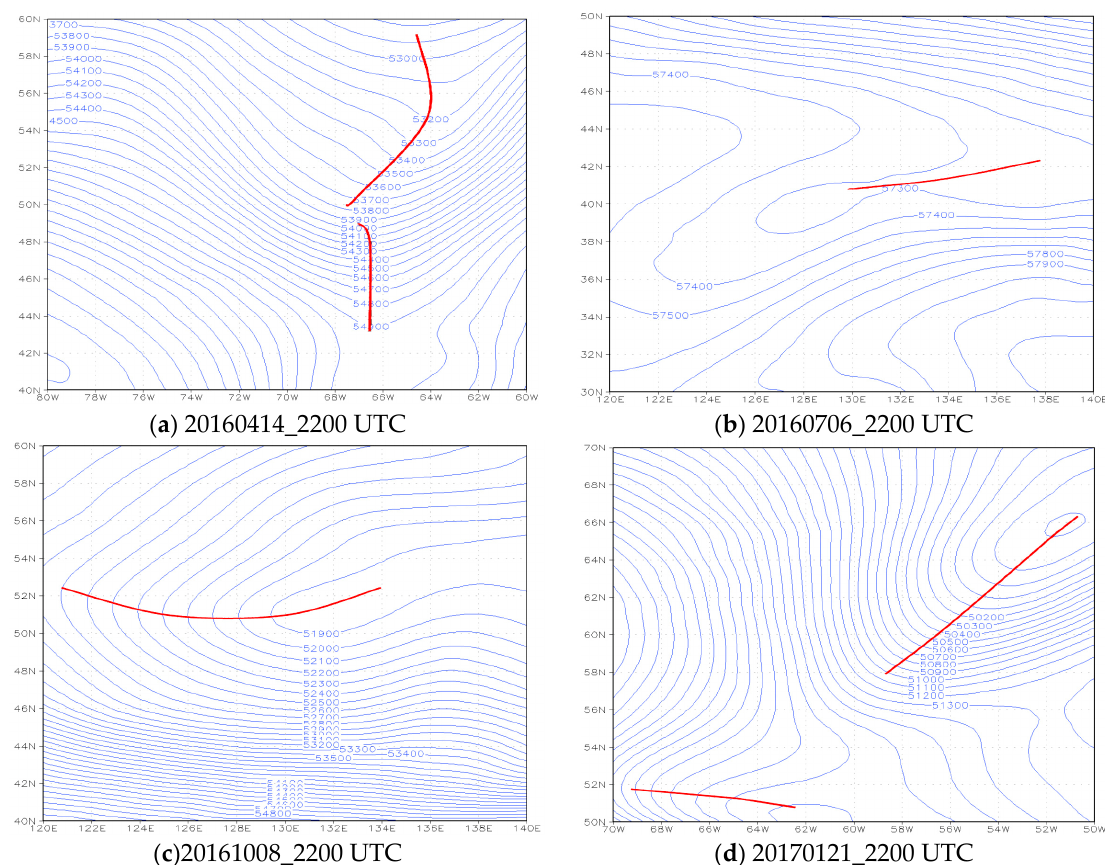
Figure 6. ( a – d ) Automatic analysis results of trough line from 2200 UTC on 14 Apr 2016, 6 Jul 2016, 8 Oct 2016 and 21 Jan 2017. The examples were selected randomly from total automatic trough lines.